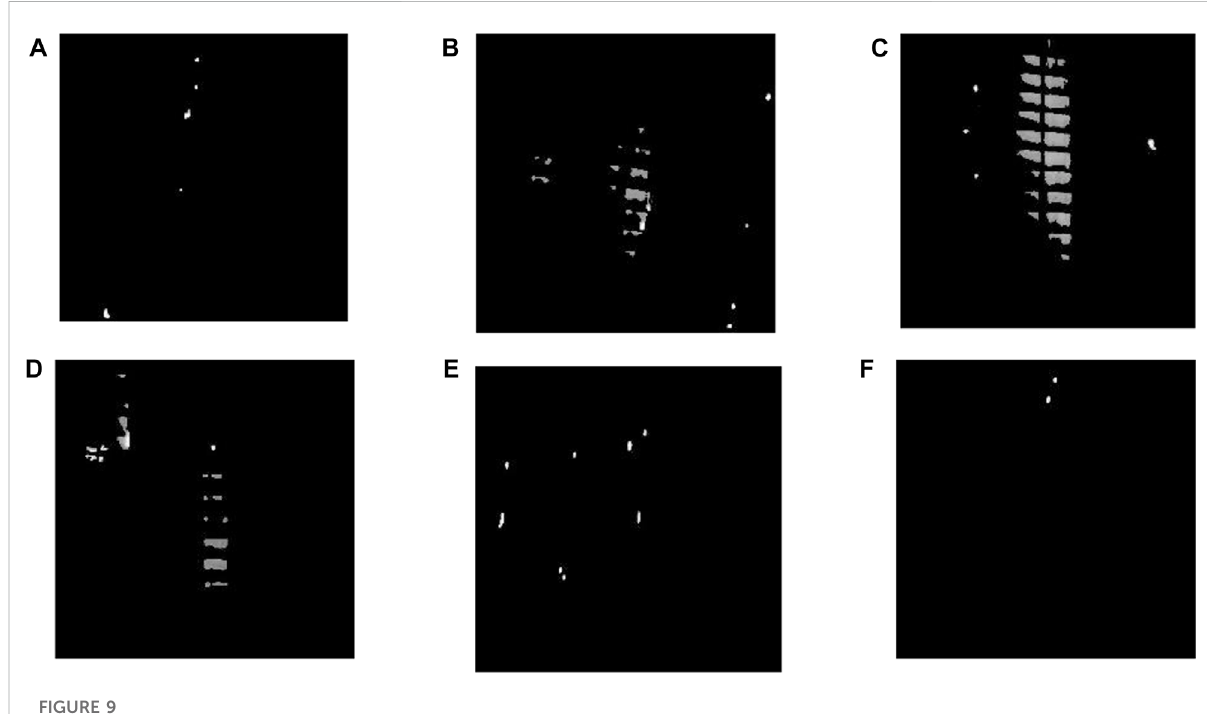
FIGURE 9 (A-F) shows the grayscale images of different image segmentation